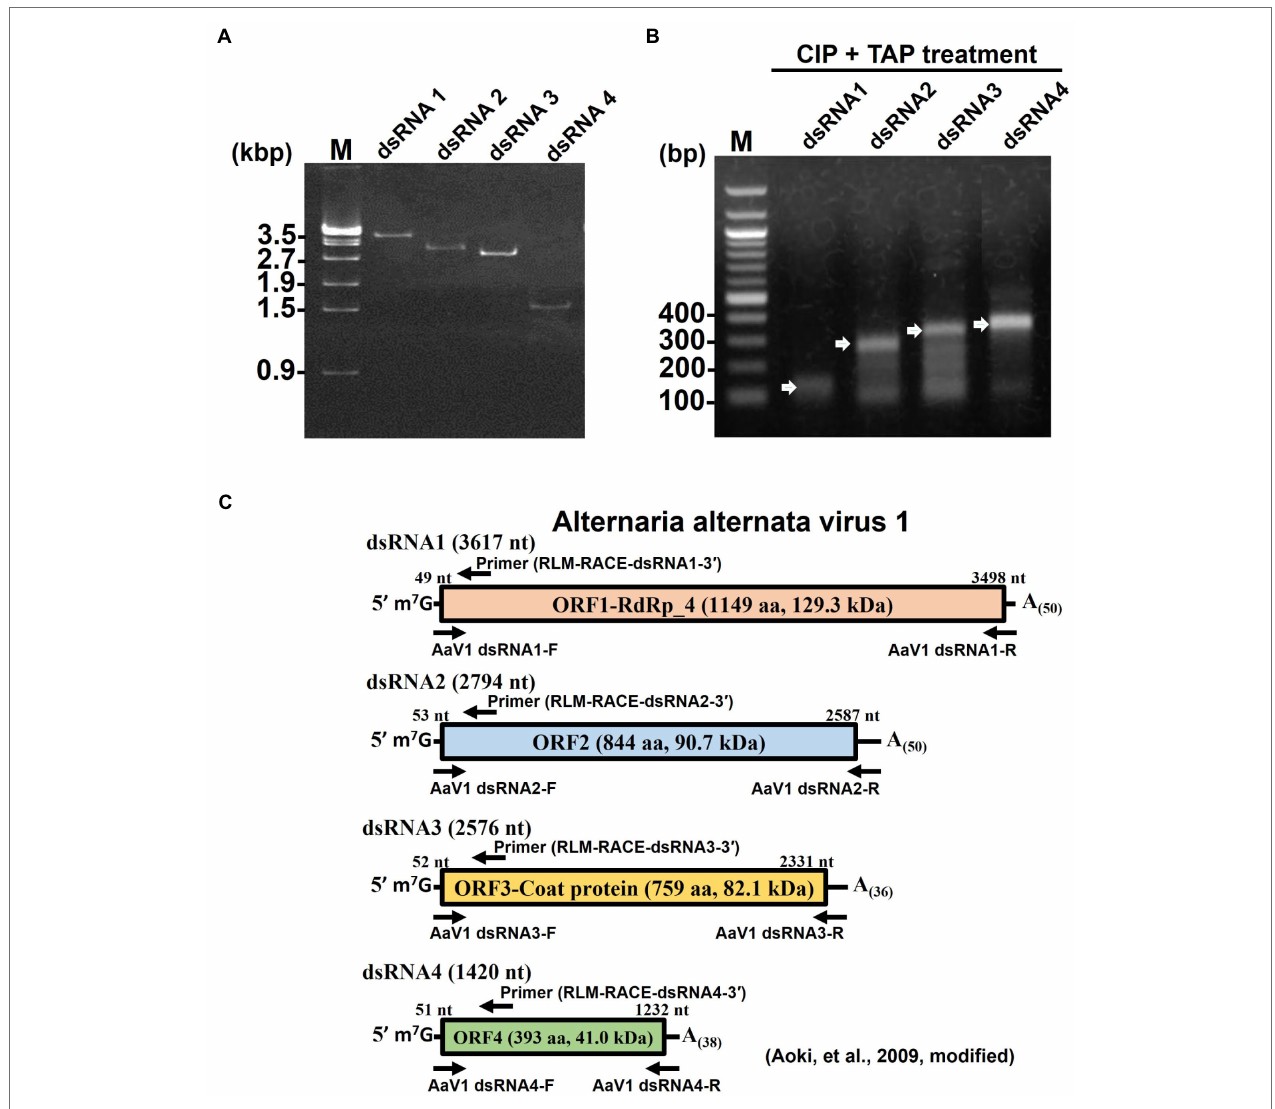
FIGURE 2 | Detection of 5 ' cap structures on each AaV1 dsRNA segment by RLM-RACE. (A) Electrophoresis of the separately excised AaV1 dsRNA segments in a 1% agarose gel with EtBr (0.5 μ g/ml) at 50 V for 1 h (Mupid-2plus, Takara Bio, Japan). (B) Results of the RLM-RACE analysis, confirming the presence of 5 ' cap structures on each AaV1 dsRNA segment. The separately excised dsRNAs were subjected to the RLM-RACE procedure ( Supplementary Figure S3 ) and then electrophoresed in a 1% agarose gel with EtBr (0.5 μ g/ml) at 100 V for 0.5 h. Lane M, 100 bp DNA ladder. The arrows indicate the amplified target bands. (C) Diagrams of the AaV1 dsRNA1, 2, 3, and 4 segments showing the primer pairs used for RLM-RACE and for amplification of each full-length dsRNA